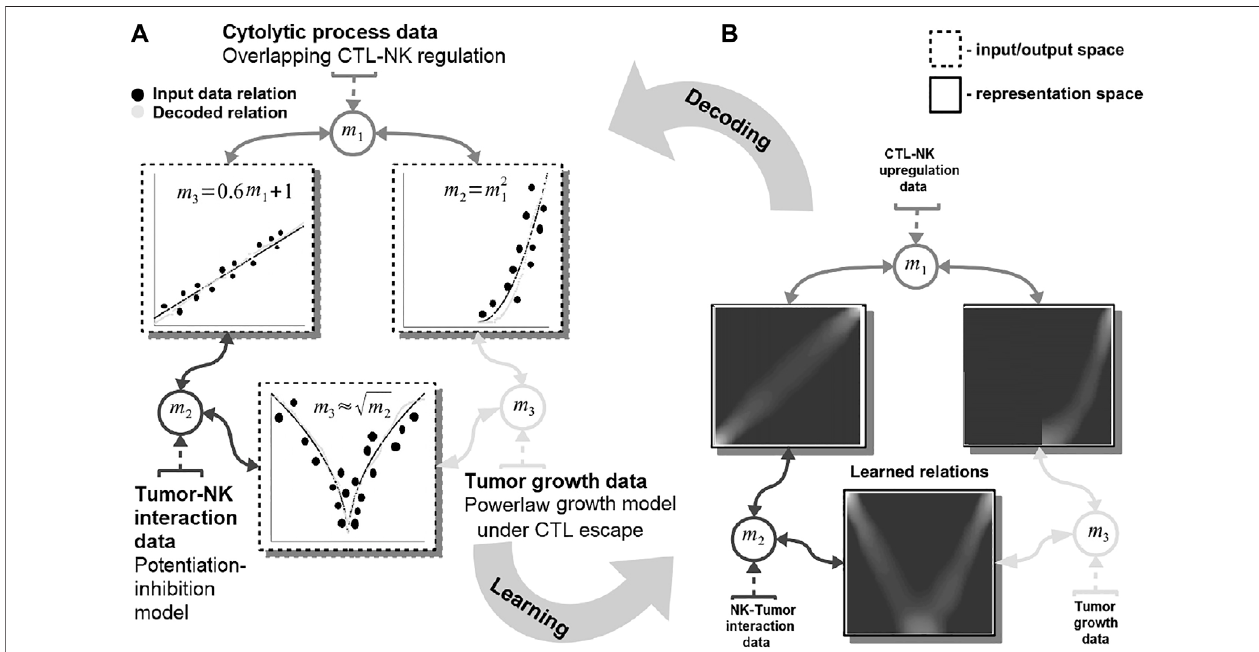
FIGURE 1 | Basic functionality of the proposed machine learning system. Data are fed in the system through the representations maps, m i which encode each quantity in a distributed (array-like) representation. The system dynamics brings all available quantities into agreement and learns the underlying mathematical relations among them [see representation space — (A) ]. The relations resemble the mathematical model of the interactions: power-law tumor growth under immune escape, nonlinear potentiation – inhibition tumor – immune interaction,and linearregulation pattern amongimmunesystem cells. The learned mathematicalrelations arethen compared with the data (i.e., the ground truth) and the mechanistic model output [see input/output space — (B) ]. Note: to simplify the visualization data points are depicted as clusters (i.e., the size of a cluster re fl ects the number of points concentrated in a region.